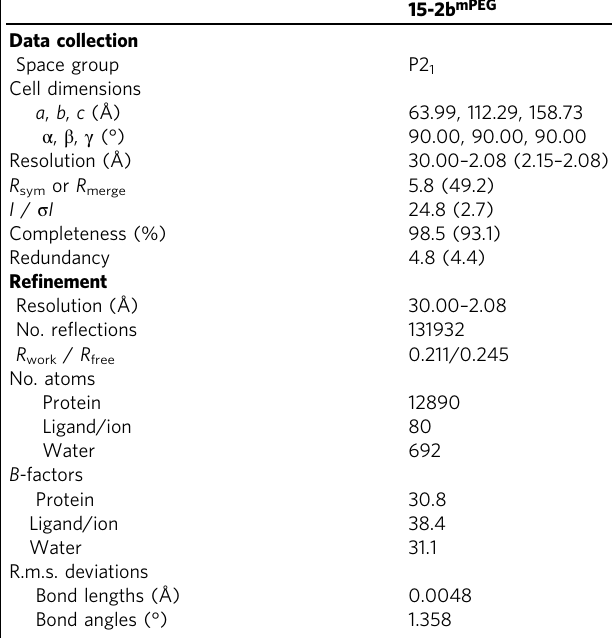
Table 1 Data collection and re fi nement